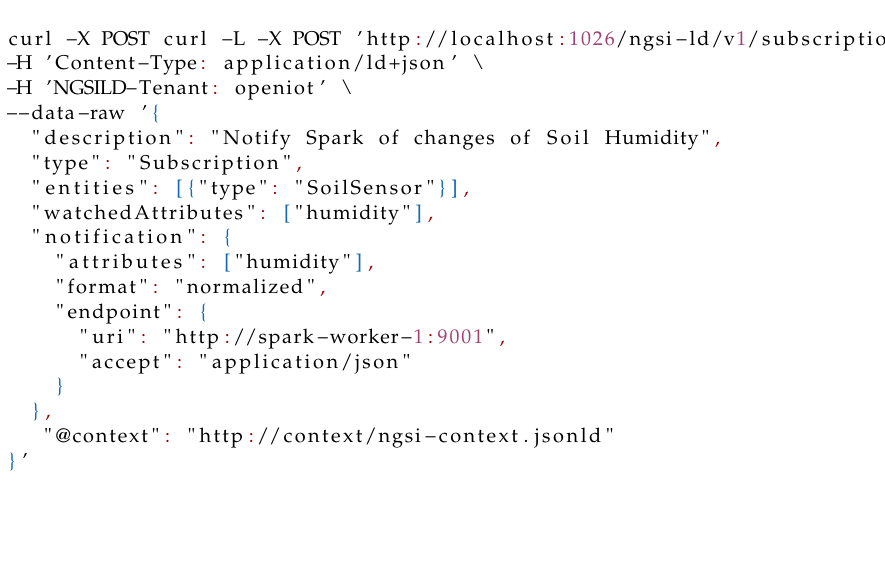
Listing 3: Subscription to the SoilSensor